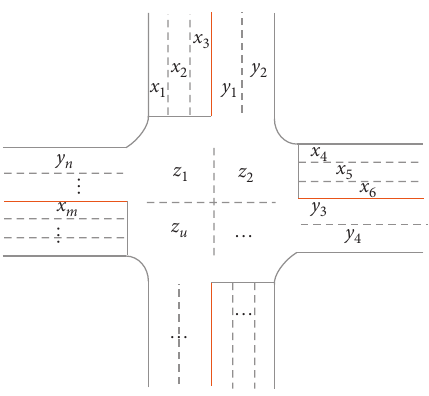
Figure 5: Extend discrete state coding to image mapping.